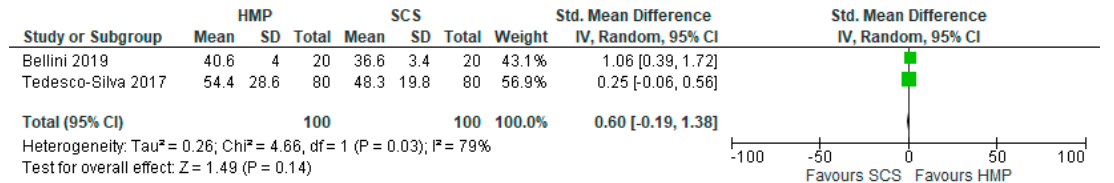
Figure 9. Estimated glomerular filtration rate (eGFR) in kidneys preserved via HMP and SCS; eGFR day 14.